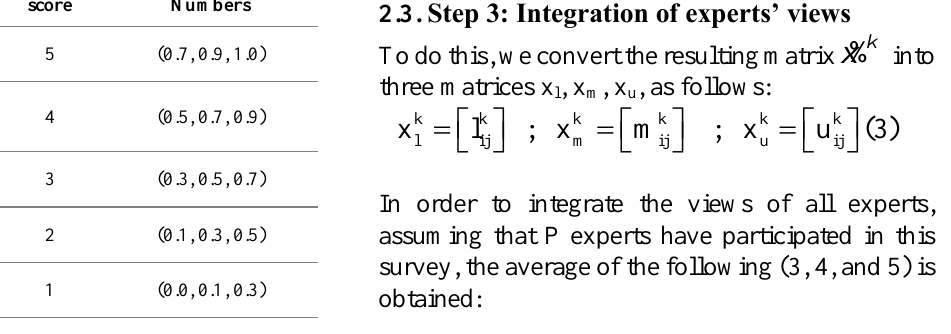
Table 1. Proposed table for the fuzzy linguistic scale. Linguistic terms